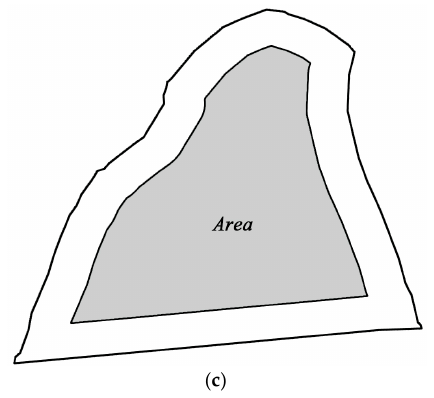
Figure 1. Schematic diagram showing the establishment of the area in which nodes must be deployed from farmland. ( a ) Field; ( b ) Vertical segment drawn from the tangent of the border of the field; ( c ) Node deployment area.